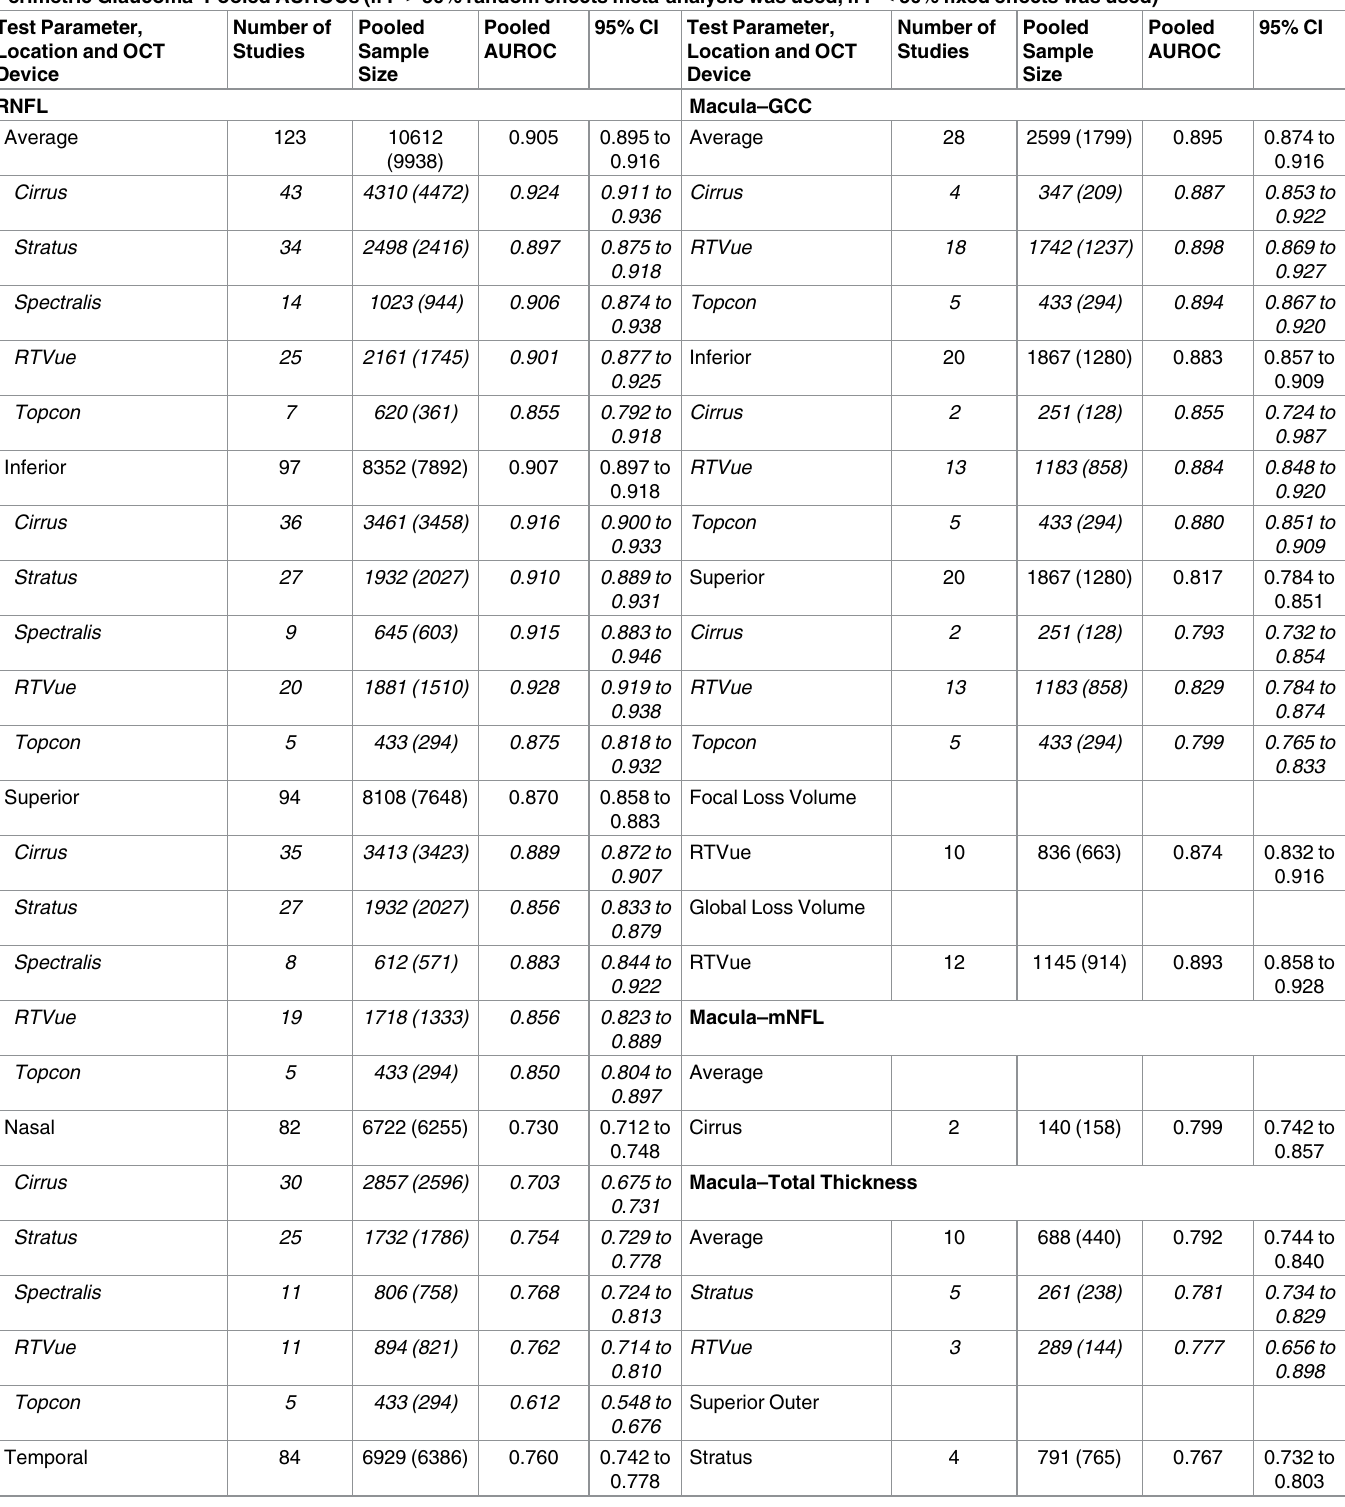
Table 3. Pooled AUROCs of RNFL and macular OCT parameters for perimetric glaucoma